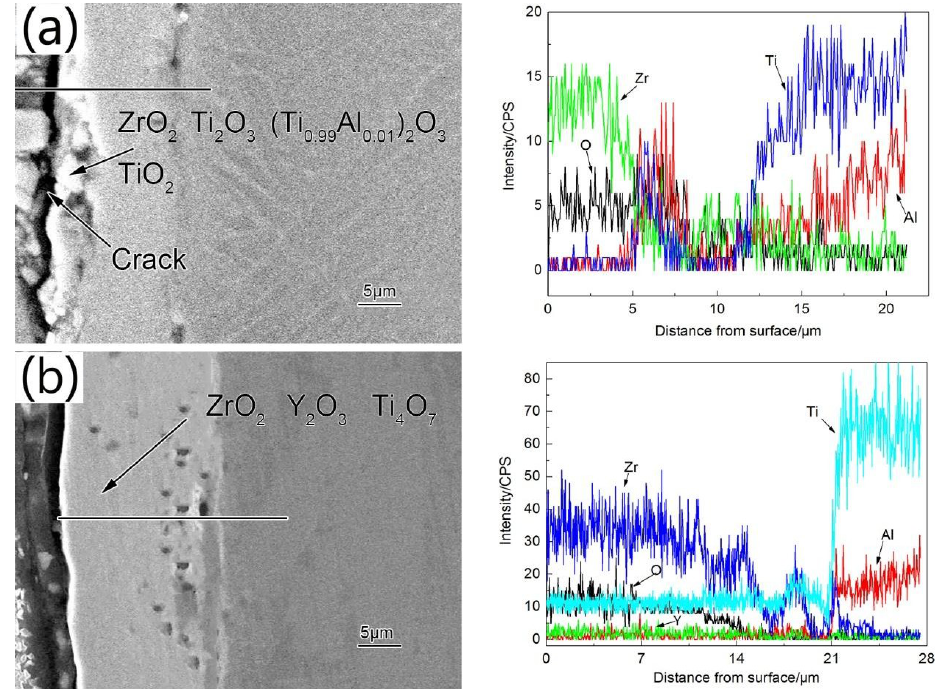
Figure 10. Cross-sectional morphologies and compositions of the specimens at 800 °C for 100 h: ( a ) Zr coating; ( b ) Zr-Y coating.